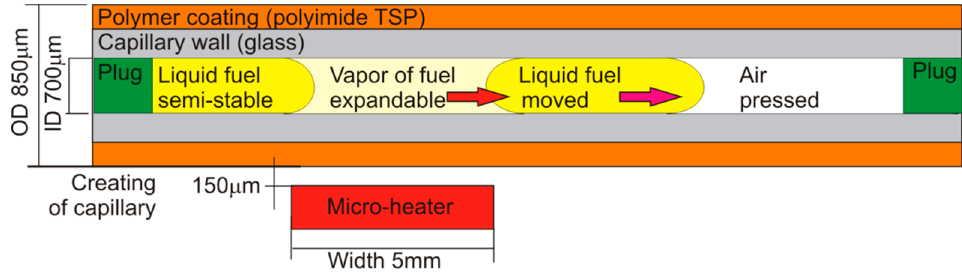
Figure 1. Diesel fuel vapor phase creation and expansion in one defined direction as a result of local sample heating.